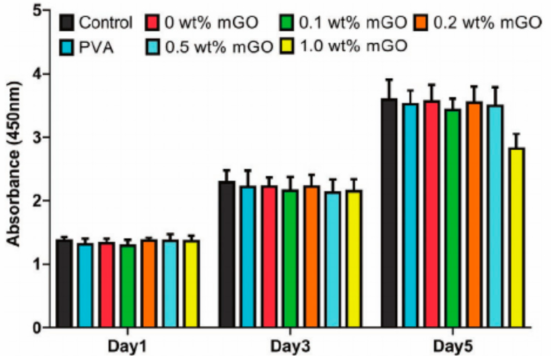
Figure 3. Cell viability of modified GO-loaded films with different concentrations [3]. Mouse preosteoblast cells seeded in contact with chitosan/GO 0.5 and 3 wt% had a significantly ( p < 0.001) higher rate of viability and proliferation than the ones in contact with chitosan control after 2 days of culture (Figure 4). This can be related to the presence of GO, which could have a role in increasing cells’ metabolic activity and proliferation [20].